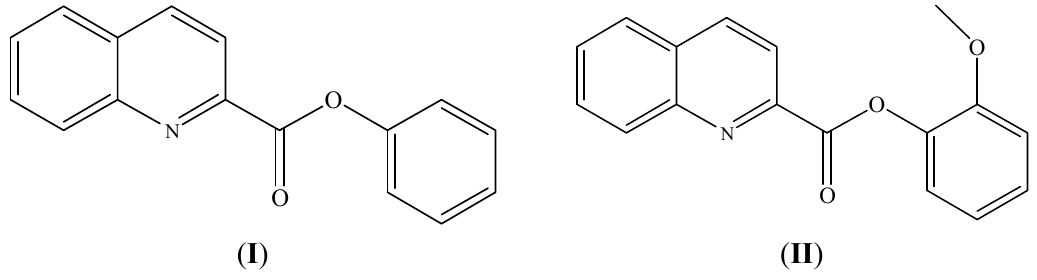
Figure 1. The molecular structures of C 16 H 11 NO 2 ( I ) and C 17 H 13 NO 3 ( II